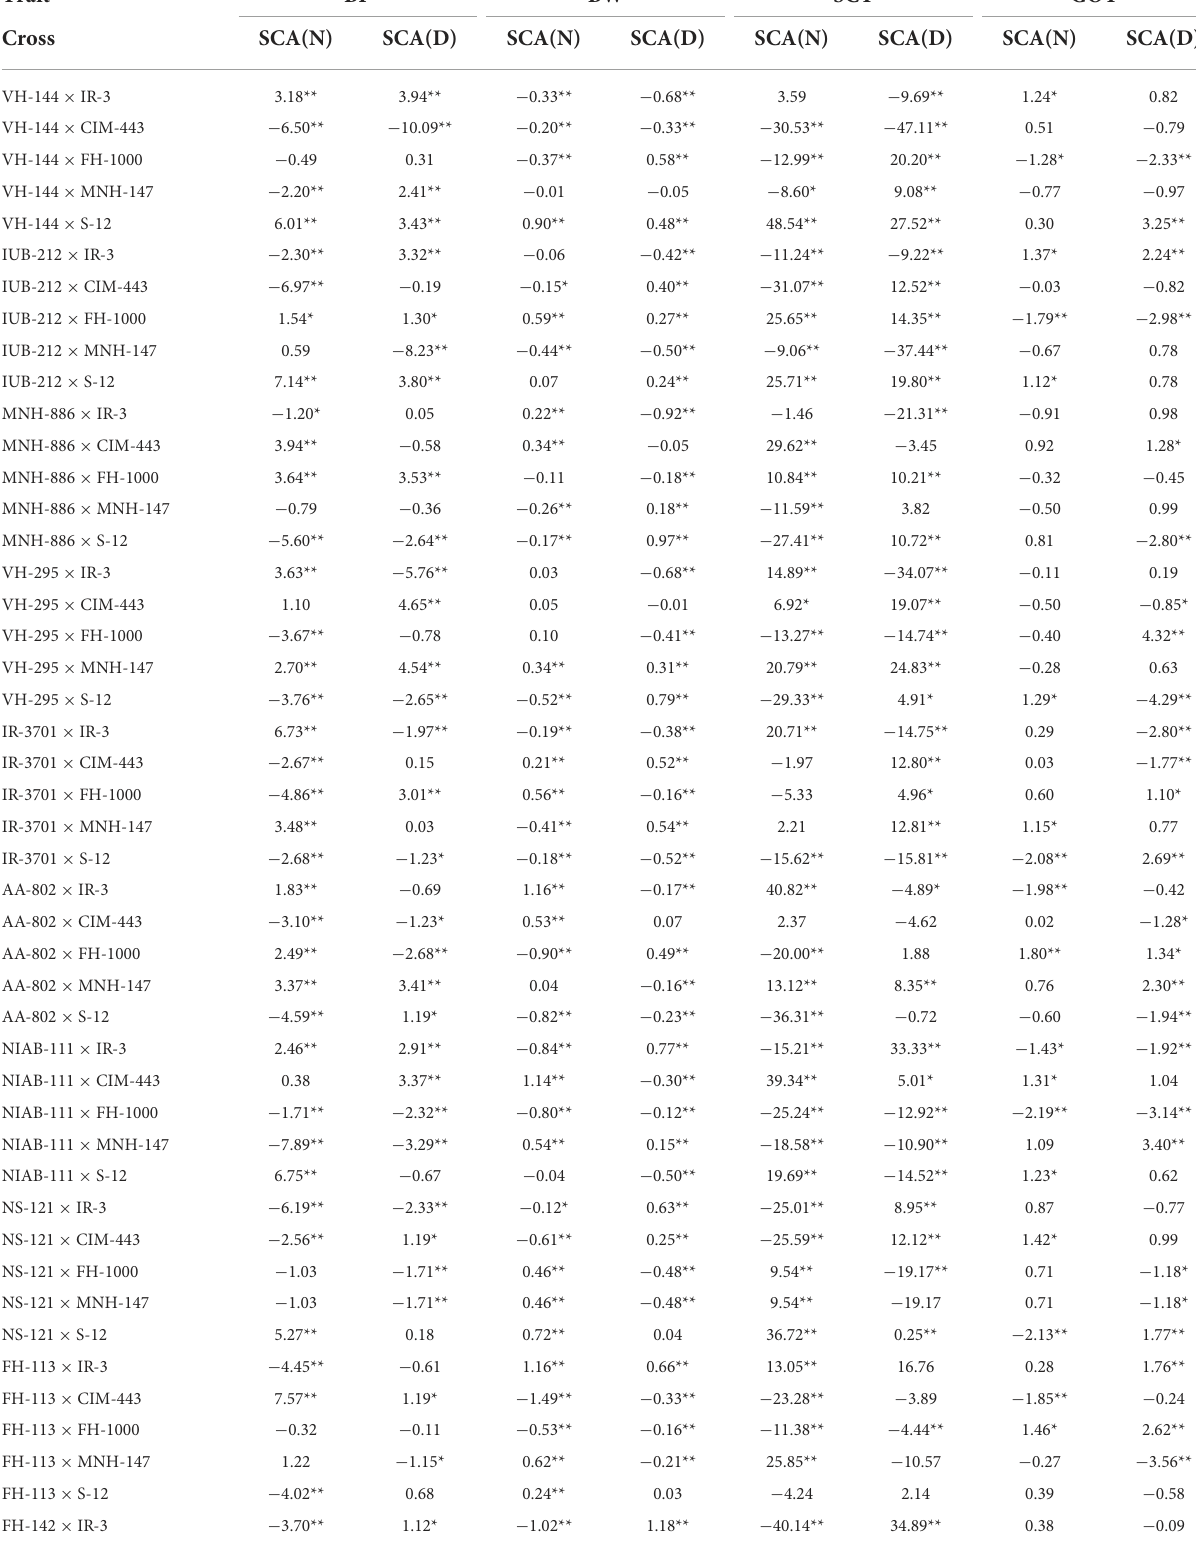
TABLE 5 Specific combining ability effects of crosses for various yield–related traits under normal (N) and water deficit (D) condition. Trait BP BW SCY GOT Cross SCA(N)